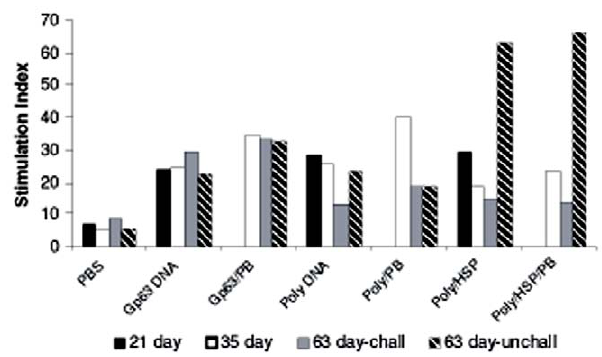
Figure 2. Splenocyte proliferation assay was performed on day 21, 35 and 63 following immunization and challenge infection in BALB/c mice. The mice were immunized with Gp63 single antigen DNA vaccine (Gp63/pcDNA) referred to as Gp63 DNA, Polytope DNA vaccine (Poly/pcDNA) referred as Poly DNA and Polytope/Hsp DNA vaccine (Poly/Hsp/pcDNA) referred as Poly/Hsp, thrice at weekly interval with and without rGp63 protein boosting as described in Materials and Methods . Splenocytes were stimulated with rGp63 protein or ConA (data not shown) and thymidine incorporation was determined. Stimulation Index represents the average counts per minute in stimulated cells divided by the average counts per minute in corresponding non-stimulated controls. The data is the mean of three experiments.